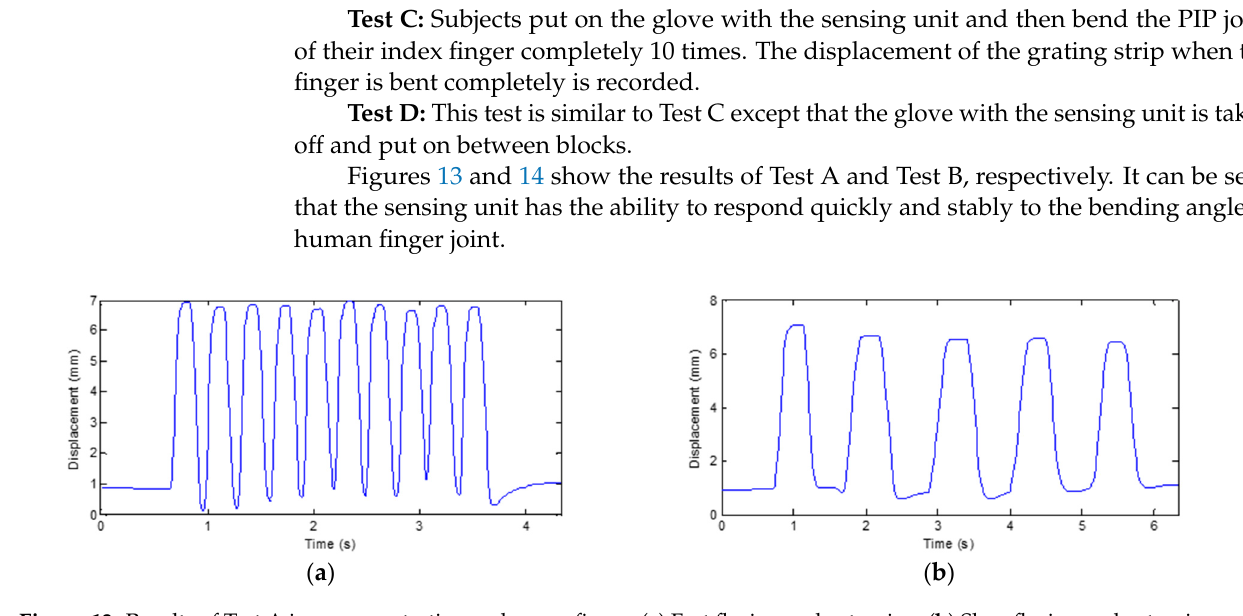
Table 1. Results of Test C and Test